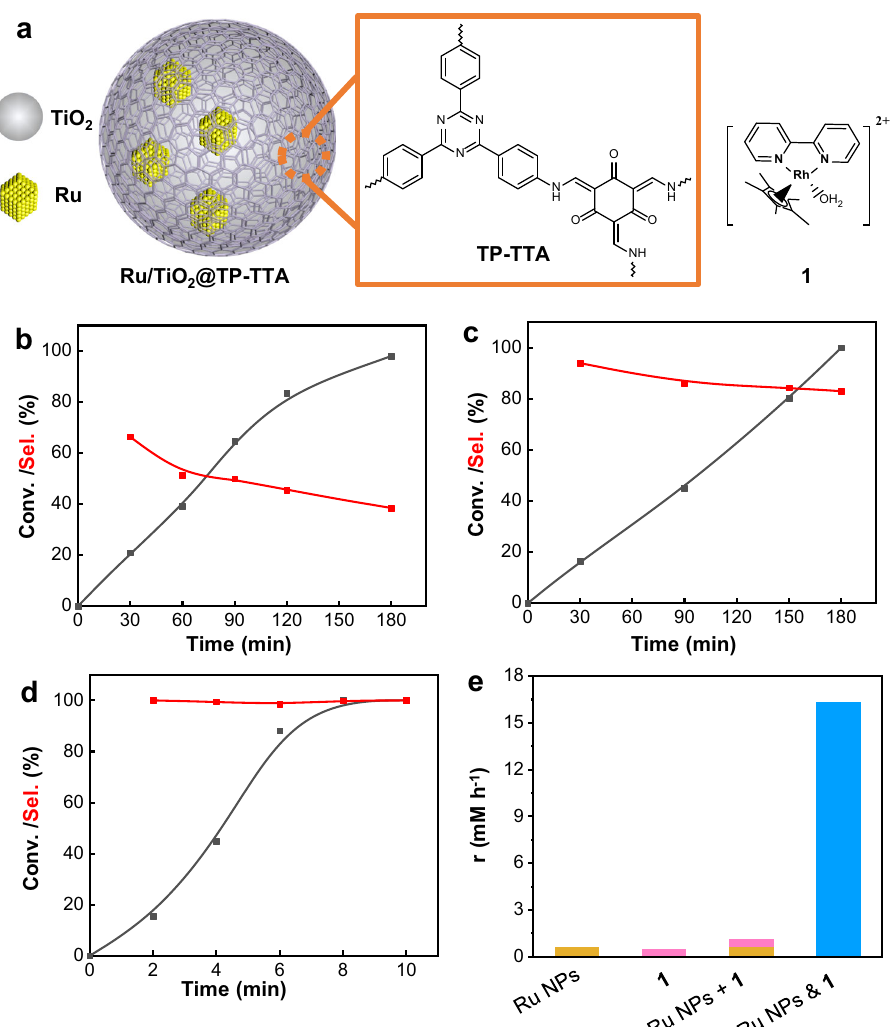
Fig. 1 | Structures andhydrogenationperformance ofRu/TiO 2 @TP-TTA and 1. a Schematic illustration of the structures of Ru/TiO 2 @TP-TTA and 1 . Reaction pro fi les of NAD + hydrogenation catalyzed by b Ru/TiO 2 @10TP-TTA, c 1 and d Ru/ TiO 2 @10TP-TTA & 1 . e Conversion rate (r) of NAD + hydrogenation of